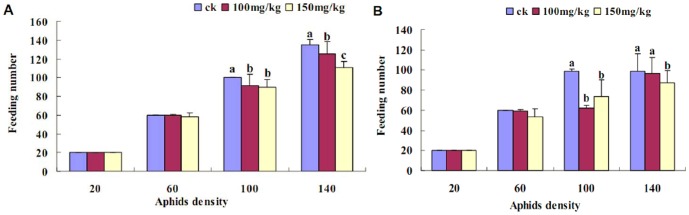
Feeding of Harmonia axyridis on aphids at different densities.
Aphis medicaginis was predated by Harmonia axyridis. Different densities of A. medicaginis adults (20, 60, 100 or 140 per tube) were exposed to either female (A) or male (B) H. axyridis adults that had been denied food for 24 h. One H. axyridis adult was put in each tube and allowed to feed on the aphids for 24 h. The number of aphids remaining was used to determine the predation rate and, therefore, the aphid survival rate. (Tukey's test, α = 0.05, a>b>c)